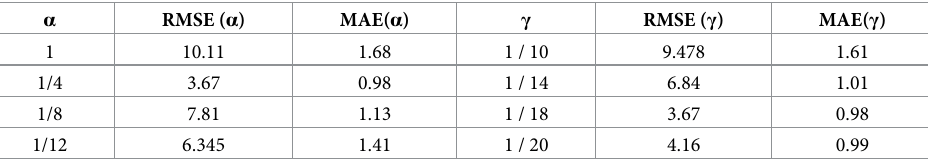
Table 5. Impact analysis of